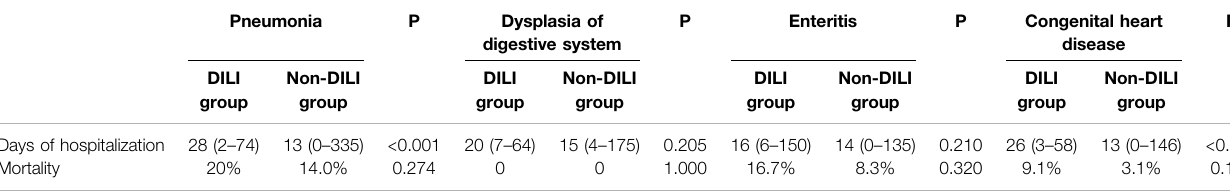
TABLE 5 | Comparison of days of hospitalization and mortality between DILI and non-DILI groups in children. Pneumonia